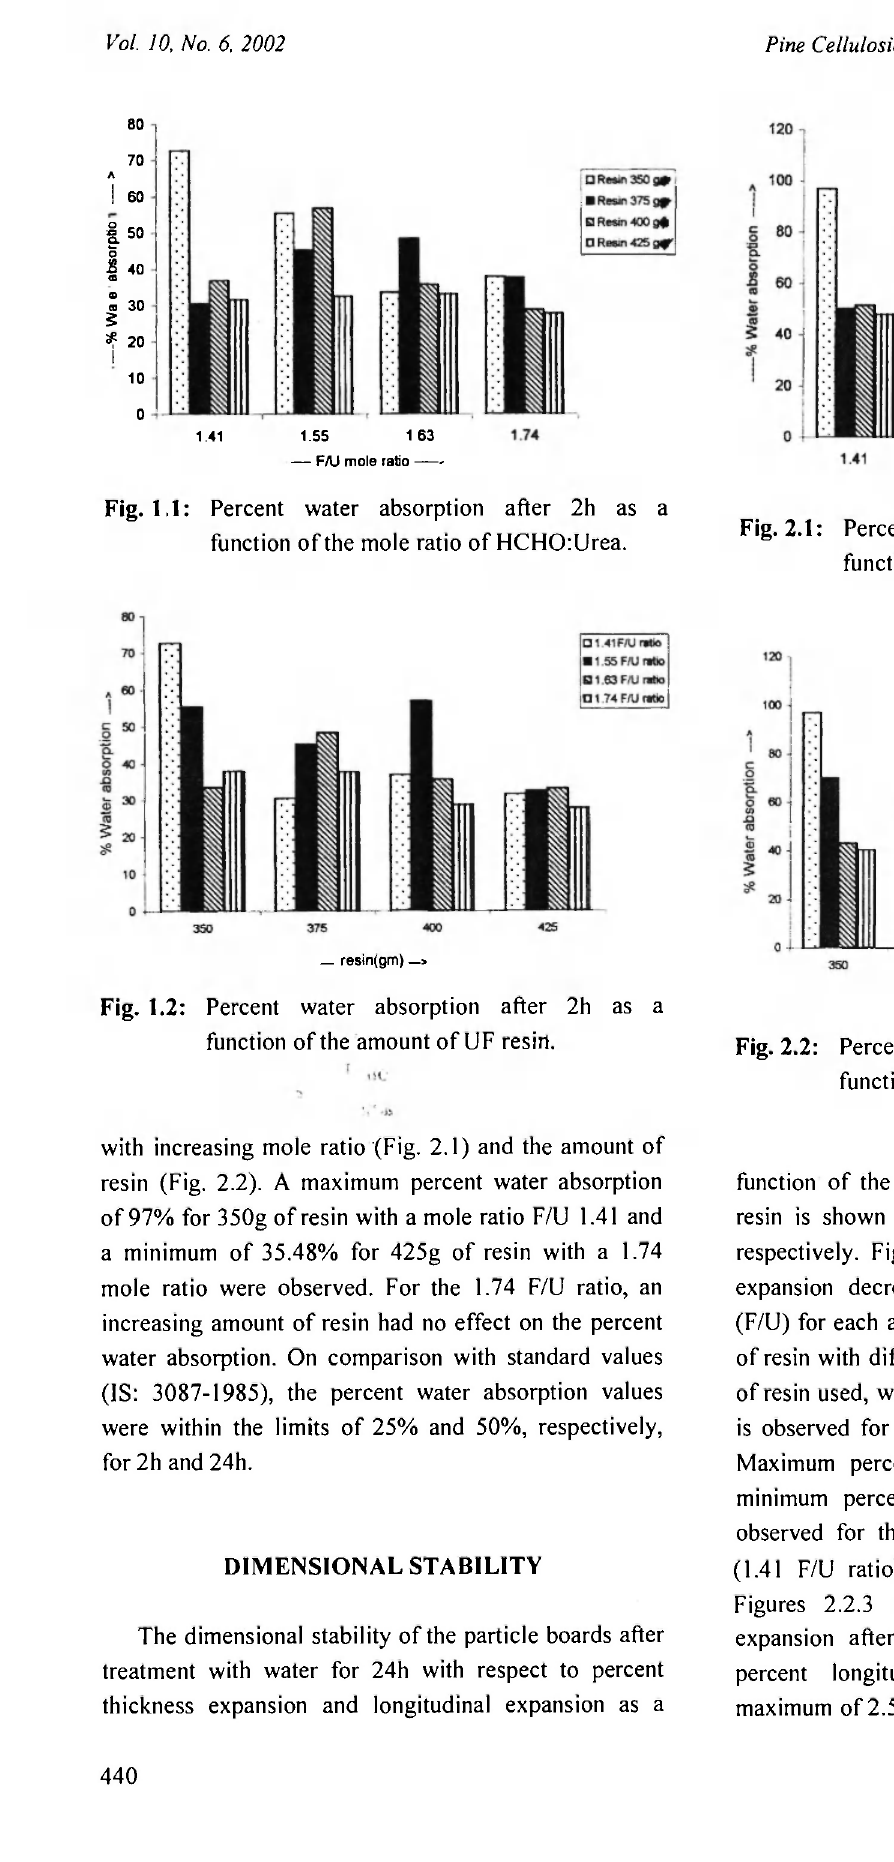
Fig. 2.1: Percent water absorption after 24h as a function of the mole ratio of HCHO:Urea.